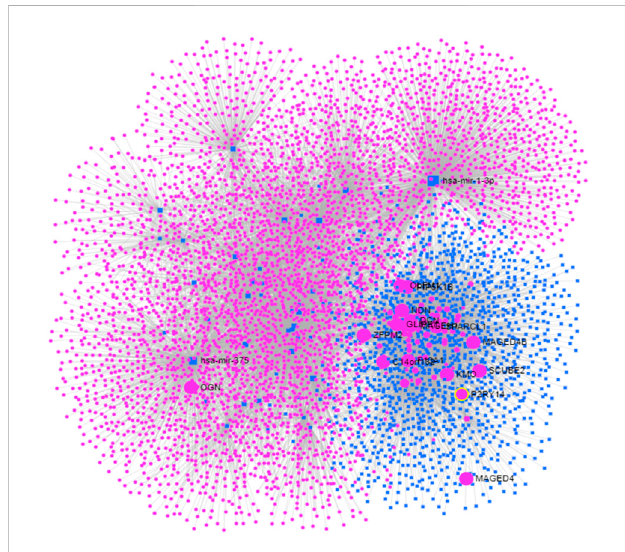
FIGURE 2 The miRNA-genes network of endometrail cancer based on signi fi cant global differential expression pro fi le of miRNAs and mRNAs. Pink circles indicate genes while blue squares refers to